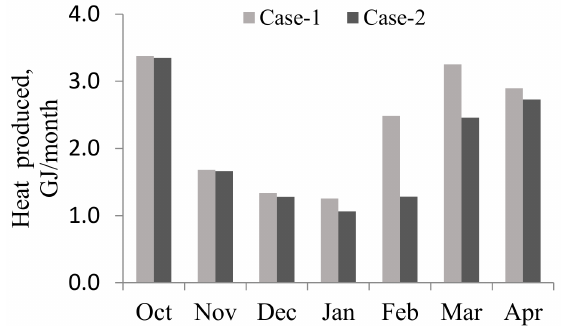
Figure 10. Monthly total thermal outputs of the collectors with daily cleaning and no